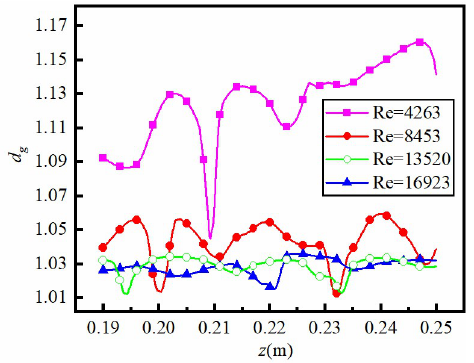
Figure 12. Distribution of geometric mean diameter. Re = 4363 (case 4 in Table 1), Re = 8453 (case 5), Re = 13,520 (case 1), Re = 16,923 (case 6).